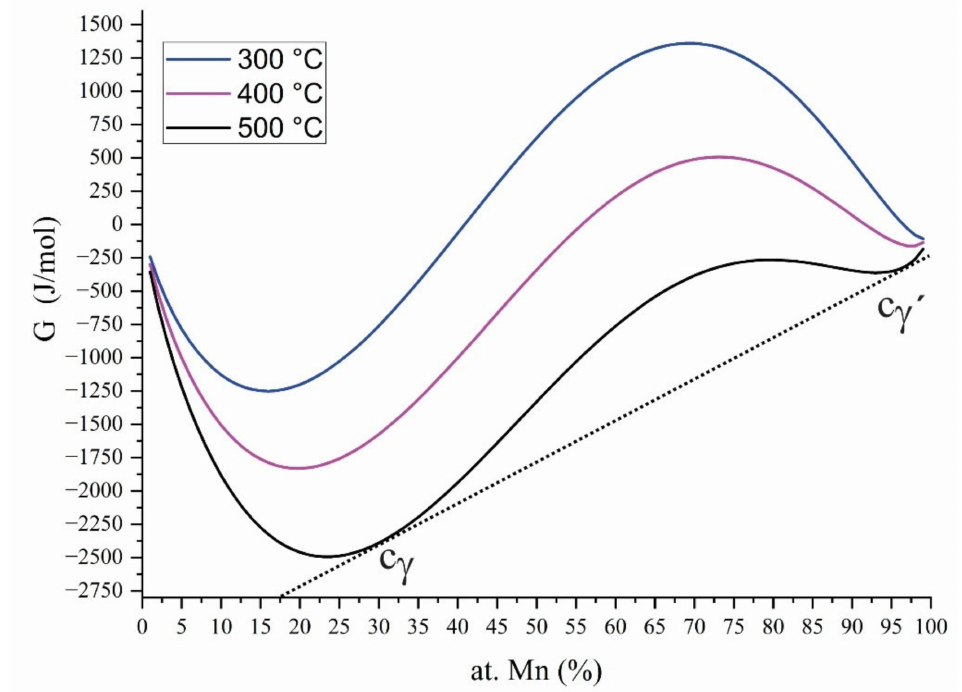
Figure 1. Composition-dependence of the free energy curves at 300 ◦ C, 400 ◦ C and 500 ◦ C. Where c γ and c γ ’ are the equilibrium compositions of γ and γ ’ phases